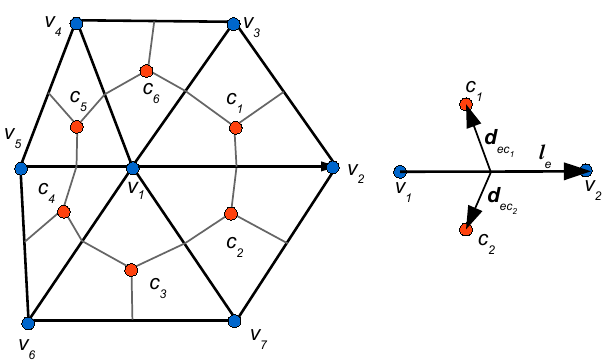
Figure 1. Schematic of cell–vertex discretization (left) and the edge-based structure (right). The horizontal velocities are located at cell (triangle) centers (red circles) and scalar quantities (the ele- vation, pressure, temperature and salinity) are at vertices (blue cir- cles). The vertical velocity and the curl of horizontal velocity (the relative vorticity) are at the scalar locations too. Scalar control vol- umes (here the volume associated with vertex v 1 is shown) are obtained by connecting the cell centers with midpoints of edges. Each cell is characterized by the list of its vertices v(c) , which is (v 1 ,v 2 ,v 3 ) for c = c 1 , and the list of its nearest neighbors n(c) . For c = c 1 , n(c) includes c 2 , c 6 and a triangle (not shown) across the edge formed by v 2 and v 3 . One can also introduce c(v) , which is (c 1 ,c 2 ,c 3 ,c 4 ,c 5 ,c 6 ) for v = v 1 , and other possible lists. Edge e (right panel) is characterized by the list of its vertices v(e) = (v 1 ,v 2 ) and the ordered list of cells c(e) = (c 1 ,c 2 ) with c 1 on the left. The edge vector l e connects vertex v 1 to vertex v 2 . The edge cross-vectors d ec and d ec connect the edge midpoint to the re- 1 2 spective cell